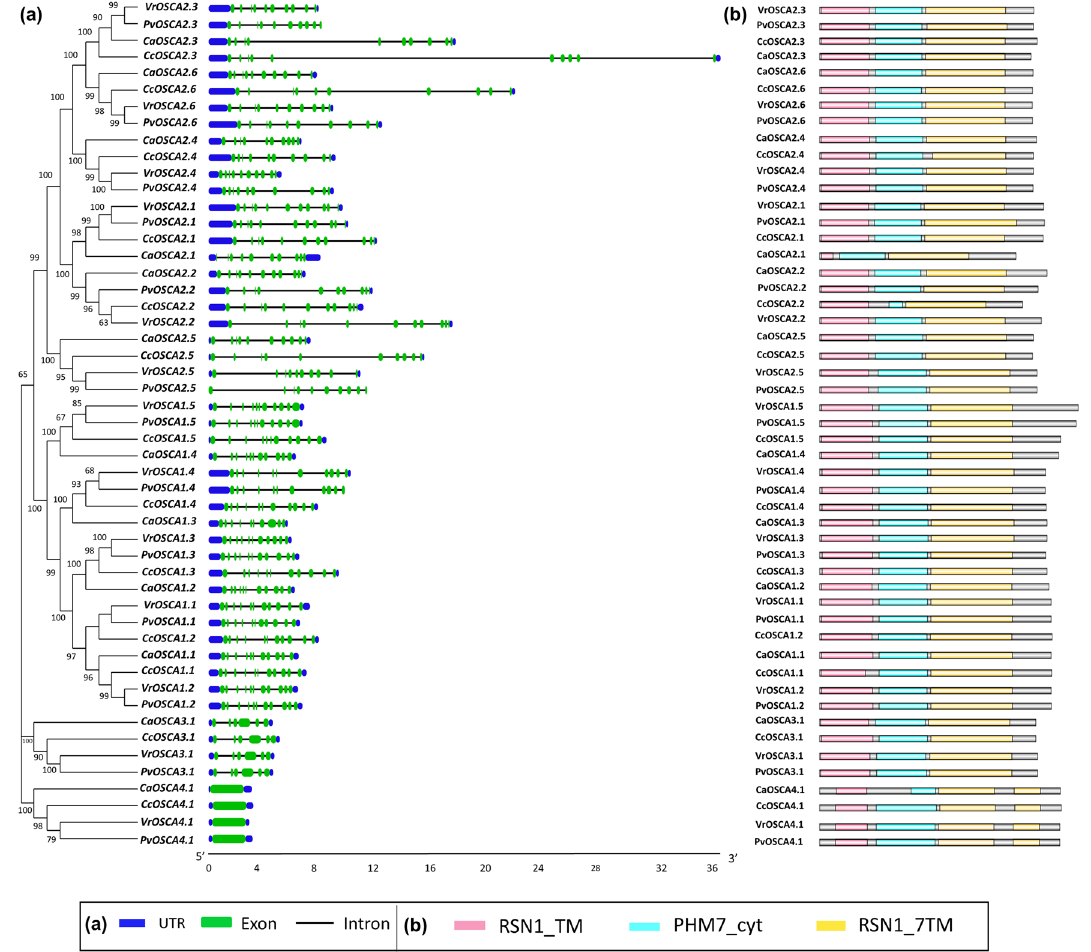
Figure 2. ( a ) Structural features of OSCA genes in legumes showing exon–intron organization in 51 OSCA genes of four legumes, and gene names are mentioned at the left. Coding sequences (CDS) and untranslated regions (UTR) were indicated by green and blue boxes respectively, and grey lines indicated introns. The scale at the bottom represents gene length in kb; ( b ) Domain organization of the OSCA protein shows three essential domains of